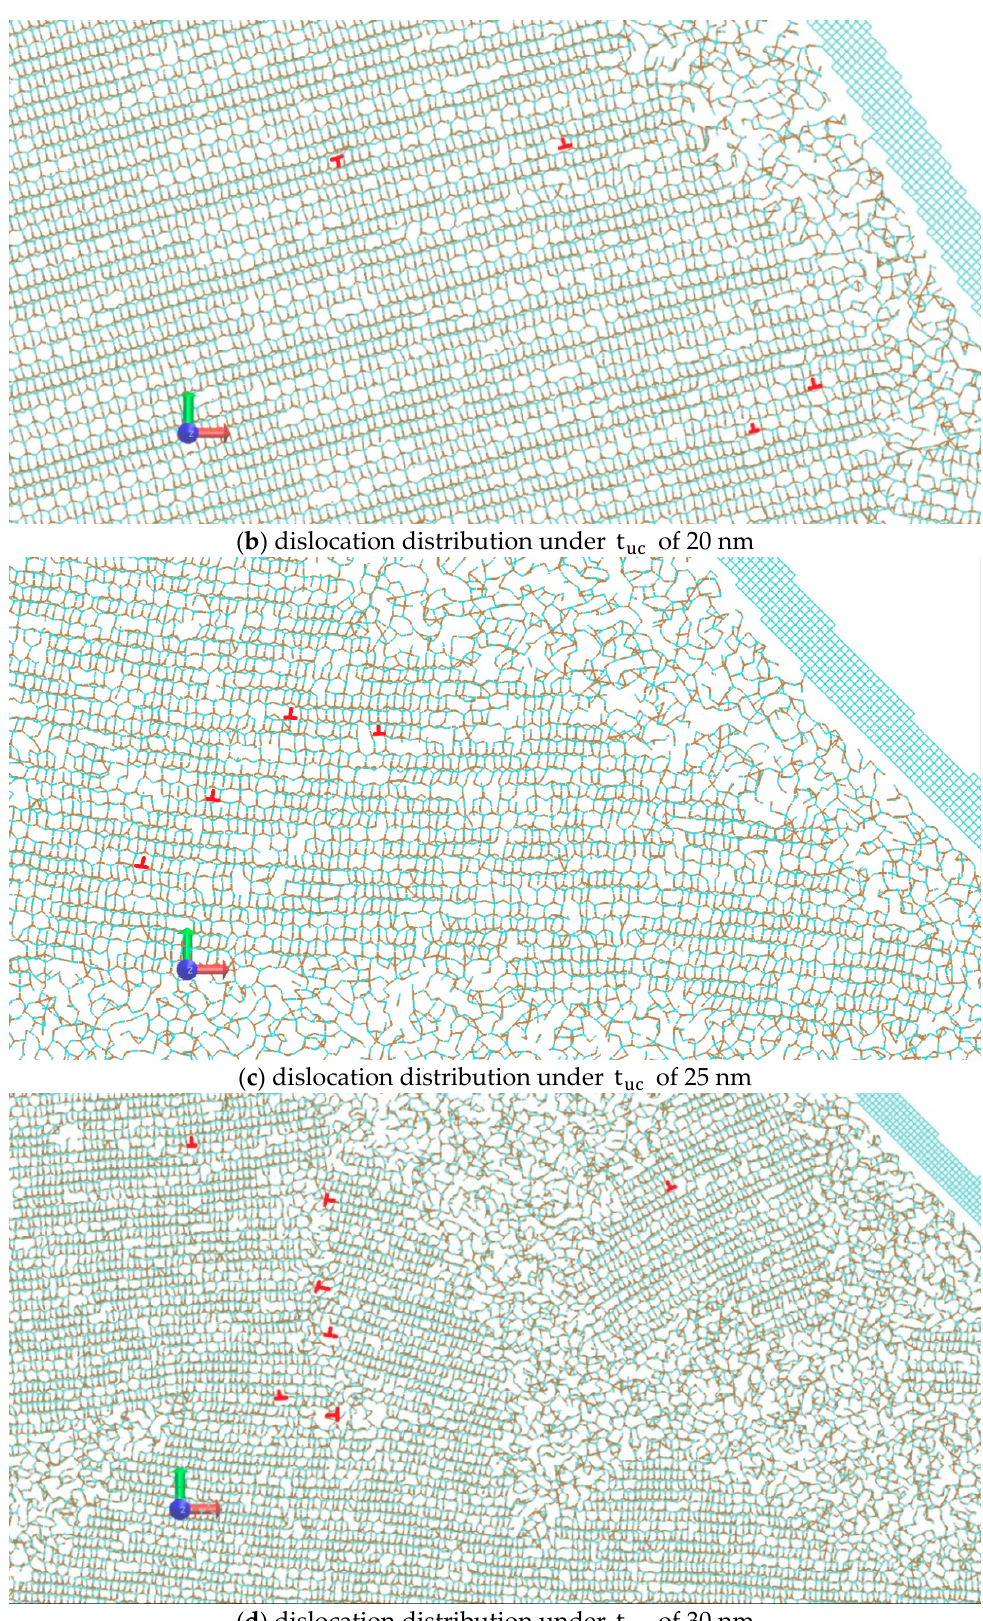
Figure 7. Dislocations in the machining zone under several t (cid:2931)(cid:2913) .